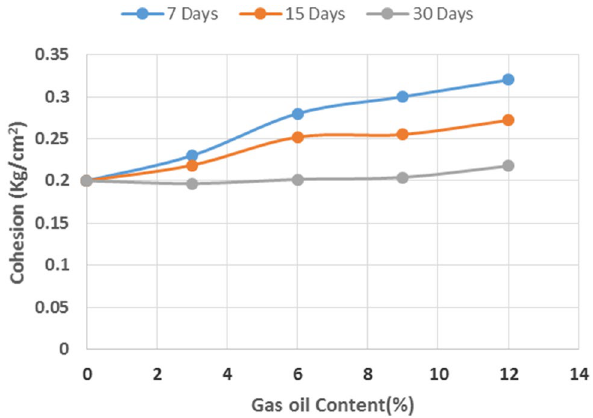
Fig. 18 Cohesion variations at different percentages of gasoline and different ages